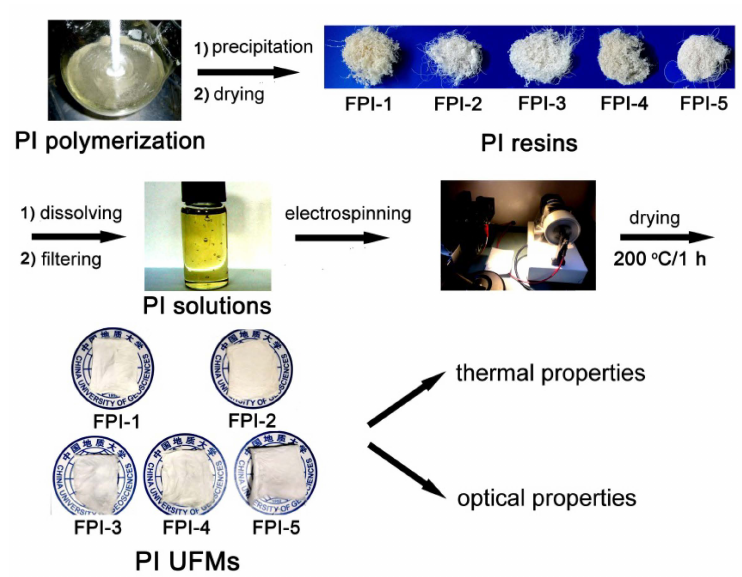
Figure 4. Fabrication procedure for the FPI UFMs.